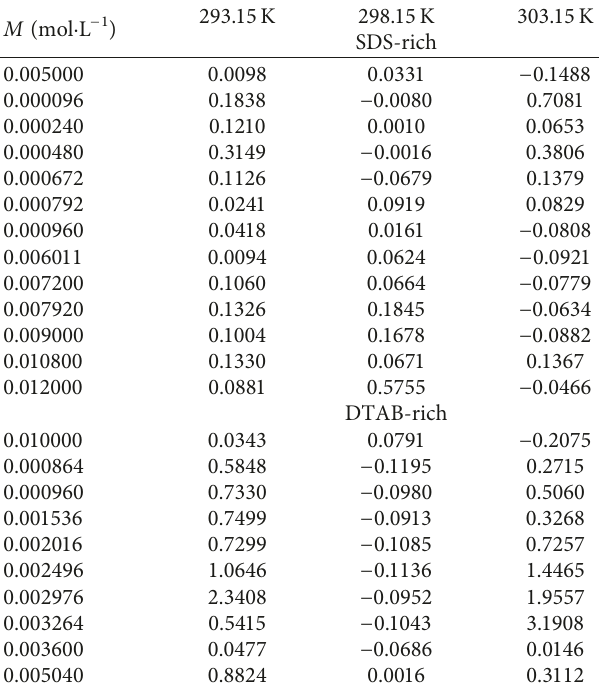
Table 9: Hydrodynamic volume ( V /nm 3 ) of SDS-rich and DTAB- h rich surfactants in the aqueous medium at the three